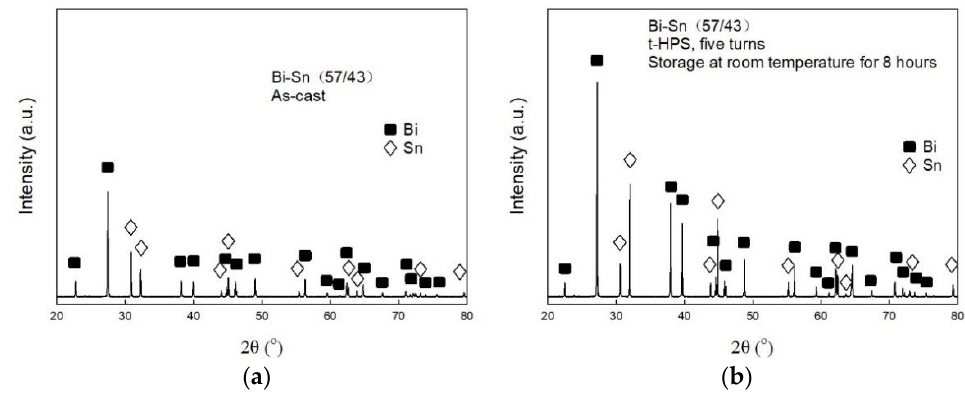
Figure 2. XRD spectrum of the Bi – Sn samples in ( a ) the as-cast condition and ( b ) after t-HPS processing for five turns and storage at RT for 8 h.